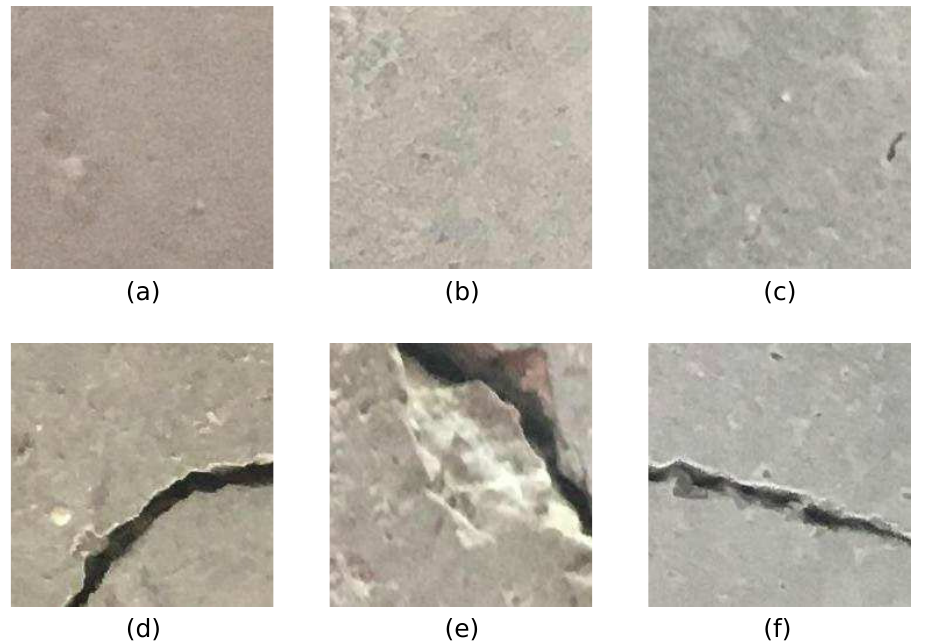
Figure 2. Some typical images from the Mendeley’s data set of “Concrete crack images for classifica- tion” [26]. Shadows are absent in all images. Parts ( a – c ) show concrete surfaces without cracks. Parts ( d – f ) show concrete surfaces with cracks.